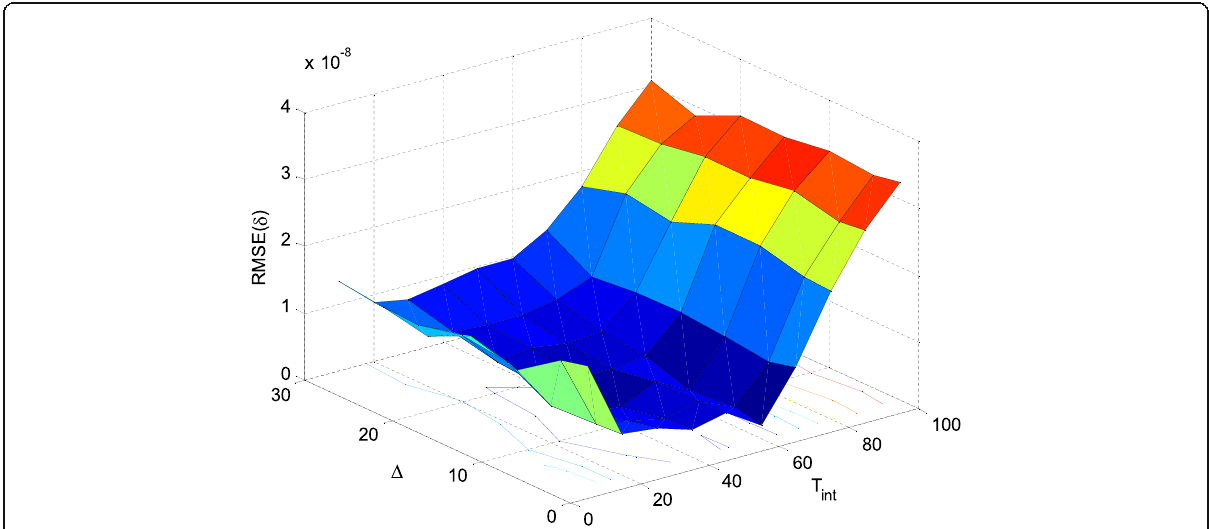
Fig. 8 RMSE of TD energy detection estimator vs. integration window length Tint and integrating step Δ , for LOS